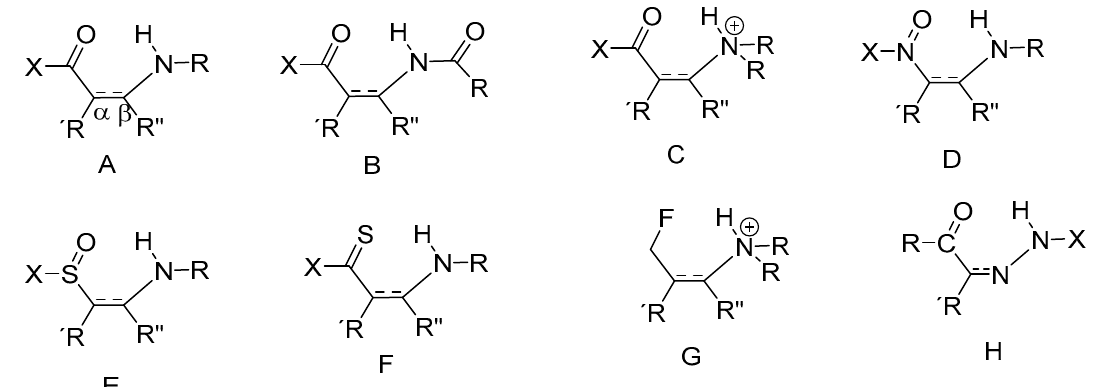
Figure 1. Intramolecular hydrogen bond scheme of RAHB type or charge assisted type. The bond between the α‐ and the β‐ carbon can be a double ‐ or an aromatic bond. ( A ) R, R’,R”=H, alkyl or aryl; X=H, C, O, N or S. ( B ) R, R´,R”=H, C,O,N; X=H or alkyl or aryl. ( C ) R=H or C; X=H or C or OR. ( D ) R, R´and R”=H or alkyl or aryl; X=lone pair or O – (nitrogen is positively charged, as it is a nitro group). ( E ) R, R´and R”=H or alkyl or aryl; X=alkyl or aryl. ( F ) R, R´and R”=alkyl or aryl; X + R`=benzene ring. ( G ) R, R´and R”=alkyl. ( H ) R and R´=alkyl, X=Ph.